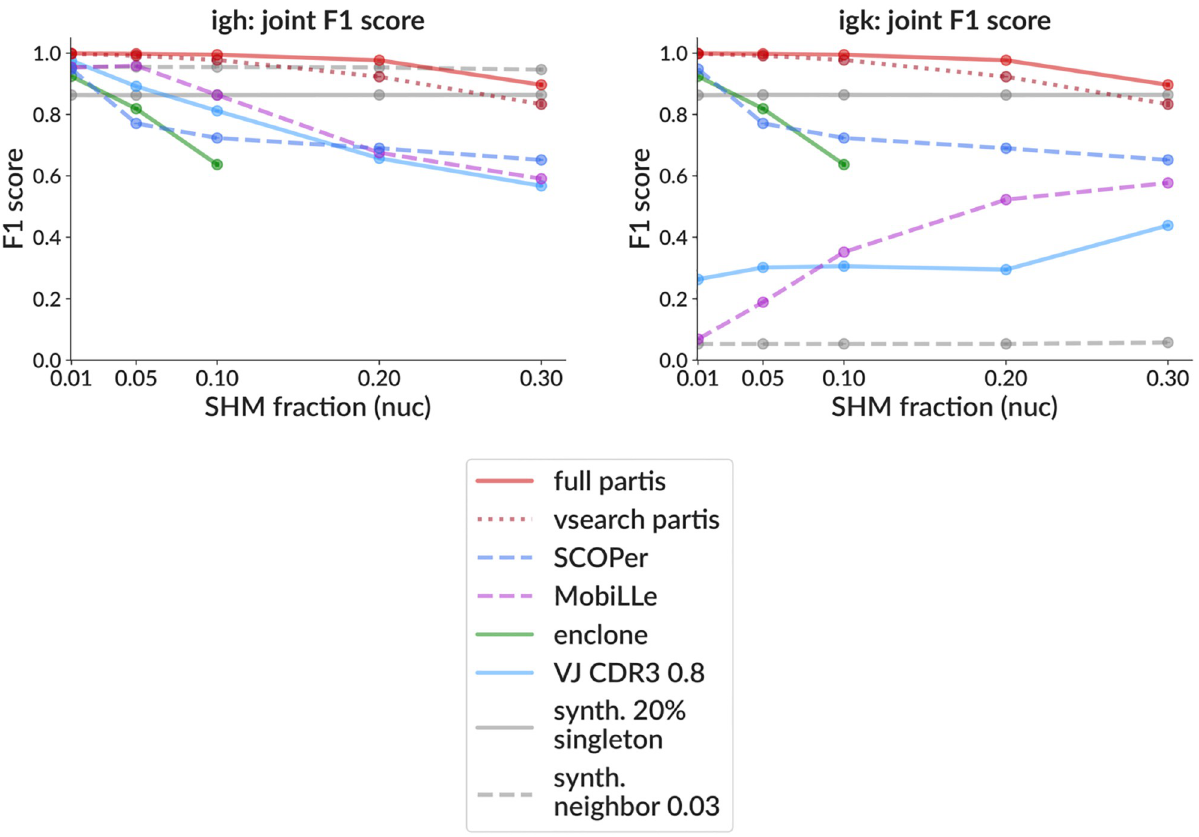
Fig 3. Clustering performance on simulation as a function of SHM (mean fraction of nucleotides mutated) for heavy chain (left) and light chain (right). Each point is the mean F1 score ( ± standard error, often smaller than points) over three samples, each consisting of 10,000 simulated rearrangement events with family sizes drawn from a geometric distribution with mean three. In addition to the inference methods (shown in color), we include two synthetic partition methods (grey), which generate incorrect partitions starting from the true partition. These are purely to provide intuitive comparison: the first splits 20% of sequences, chosen at random, into singleton clusters; the second merges together families whose true naive sequences are closer than 3% in Hamming distance (“synth.”, see text for details). The F1 score’s component precision and sensitivity are plotted in S3 Fig, while the performance with and without using pairing information is compared for partis in S4 and S7 Figs, and SCOPer in S5 Fig. Performance of partis as a function of the number of families (with SHM constant) is shown in S6 and S7 Figs. Note that enclone by design discards some sequences with higher SHM levels, so we display its performance only for those samples where it passes at least 90% of sequences (it discards ’ 9% of sequences at 10% SHM, ’ 60% at 20%, and ’ 94% at 30%).